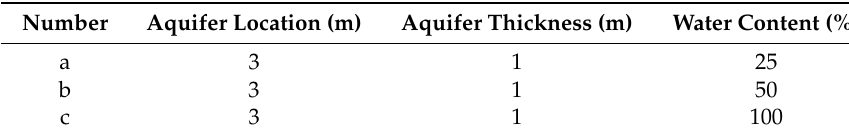
Table 1. Parameters of the theoretical models.